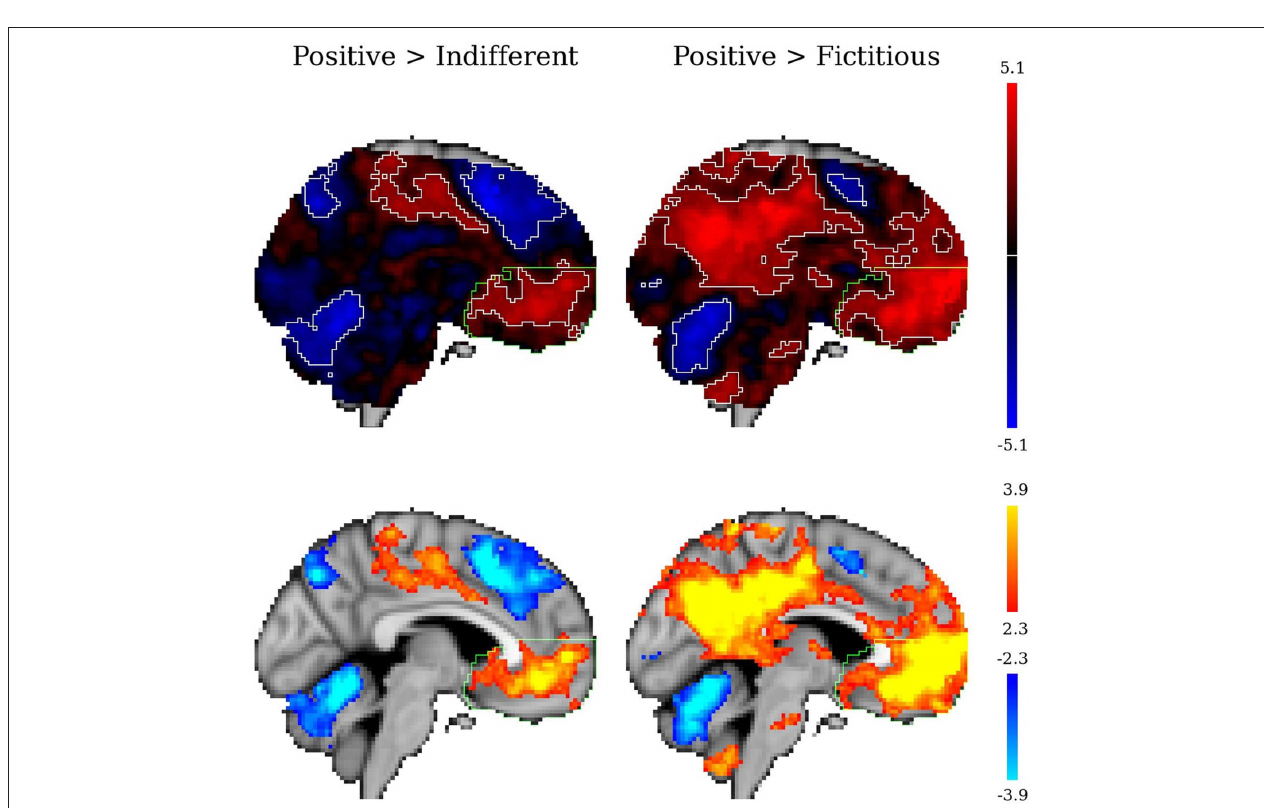
FIguRe 5 | Statistical z maps (unthresholded in the upper row and thresholded in the lower row) for the contrasts positive versus indifferent brands and positive versus fictitious logos in a conventional gLM analysis. In the unthresholded images the significant clusters are outlined in white (for z > 2.3), and the vmPFC is outlined in green. Sagittal views for x = − 04 (MNI152